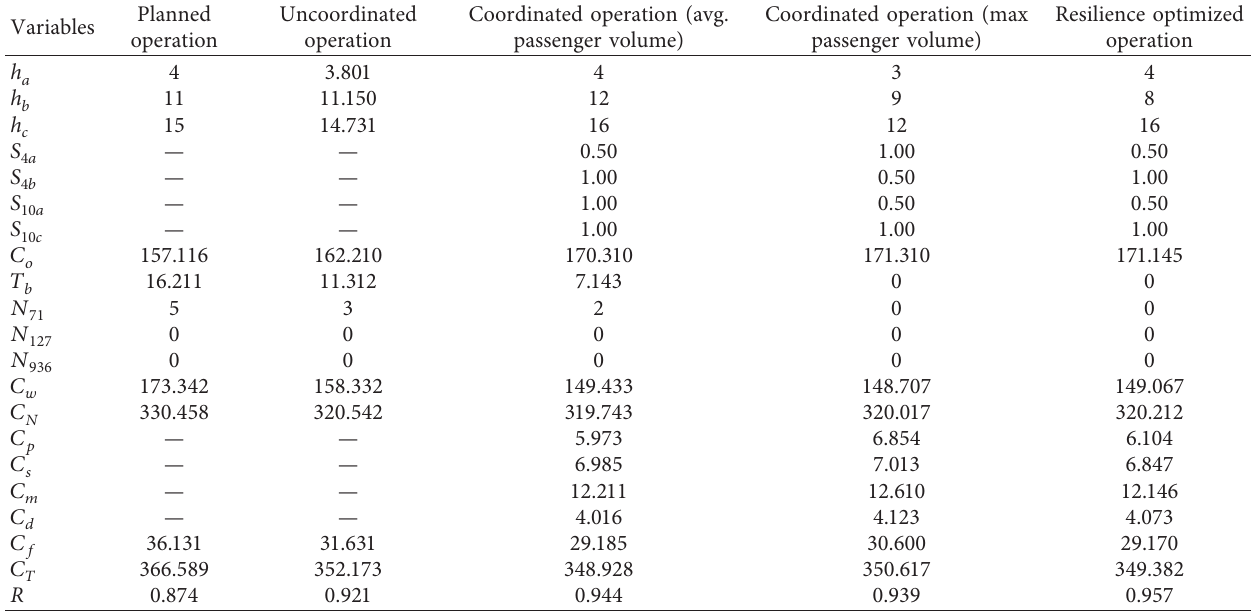
Table 3: Comparison of different operation methods after restructuring routes.